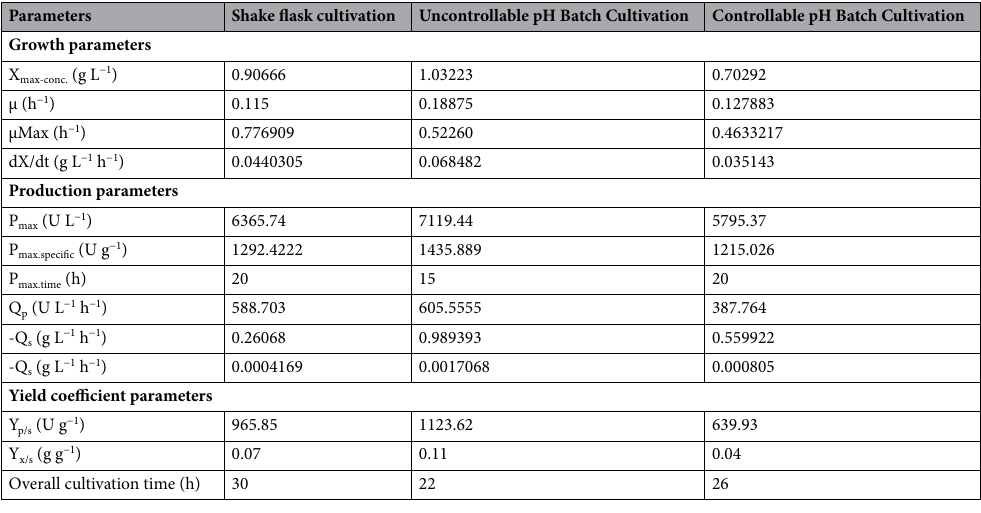
Table 5. Cell growth kinetics and ALP production parameters by Lysinibacillus sp. strain APSO as affected by different cultivation strategies. X max-conc maximal cell dry weight, dx/dt cell growth rate, µ specific growth rate, P max maximal ALP production, P max,specific specific productivity, Q p ALP production rate, Q s substrate consumption rate,